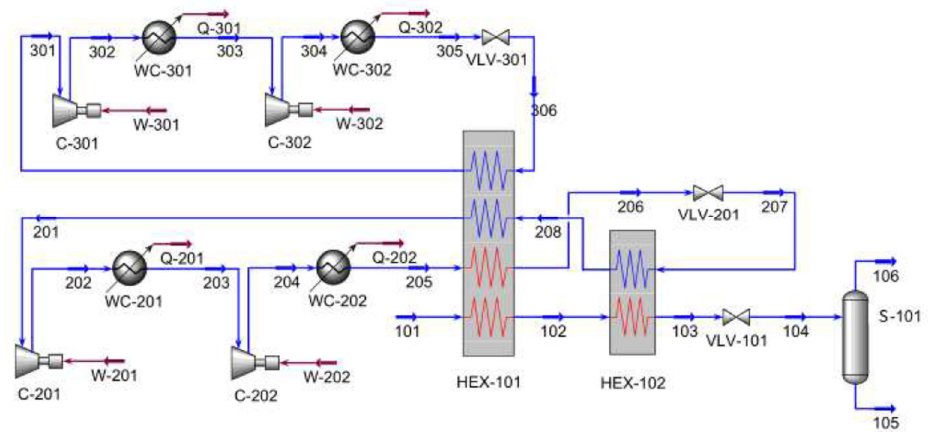
Figure 49. Cascade PLNG process [191]. Reproduced with permission from Elsevier (license num- ber